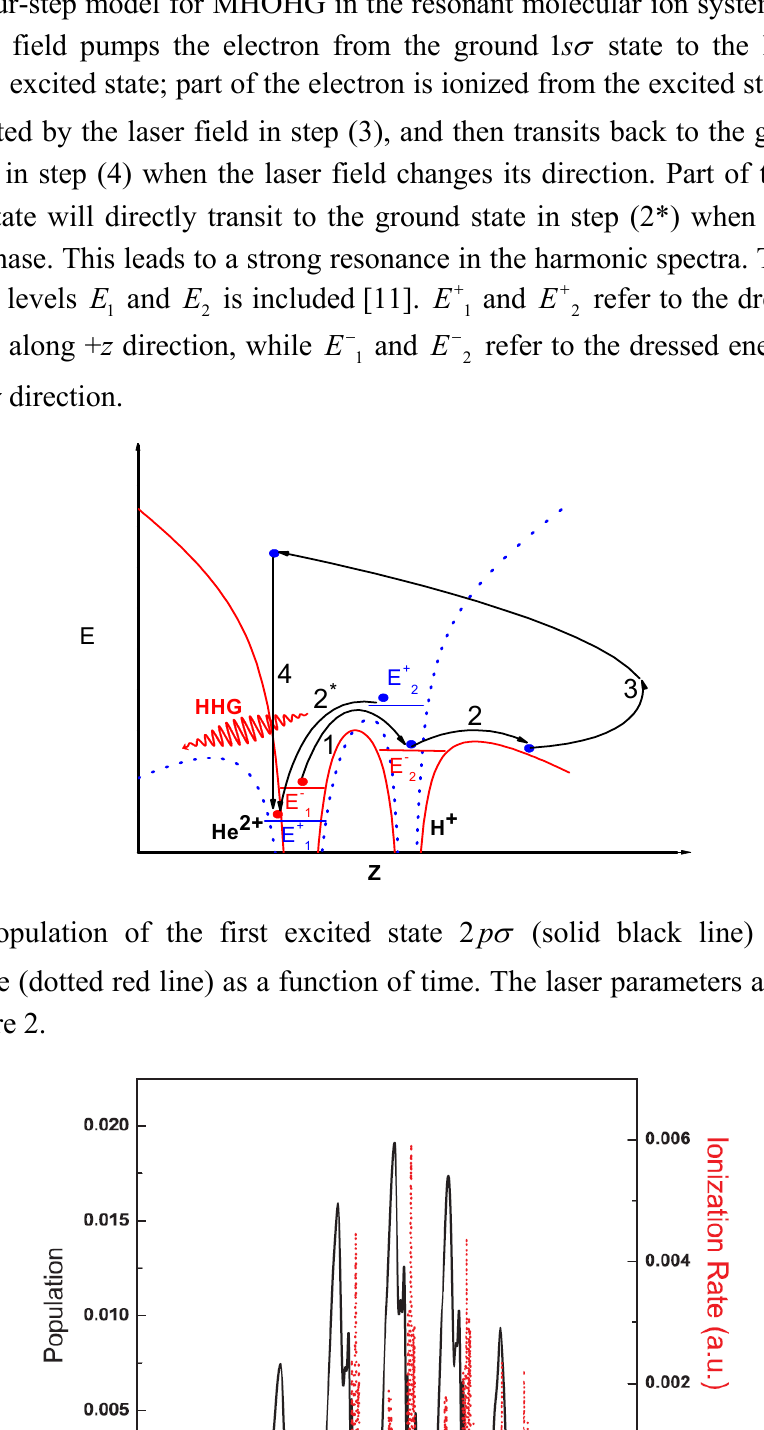
Figure 3. Four-step model for MHOHG in the resonant molecular ion system HeH 2+ . Step (1): the laser field pumps the electron from the ground 1 s  state to the localized long lifetime 2 p  excited state; part of the electron is ionized from the excited state in step (2),